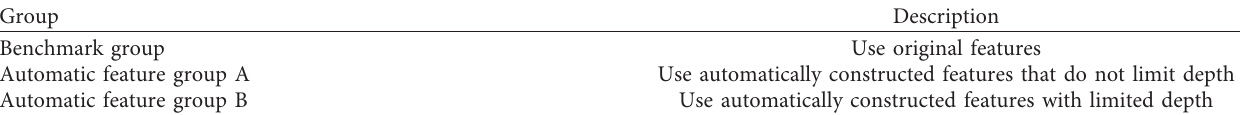
Table 6: Settings of experimental group.